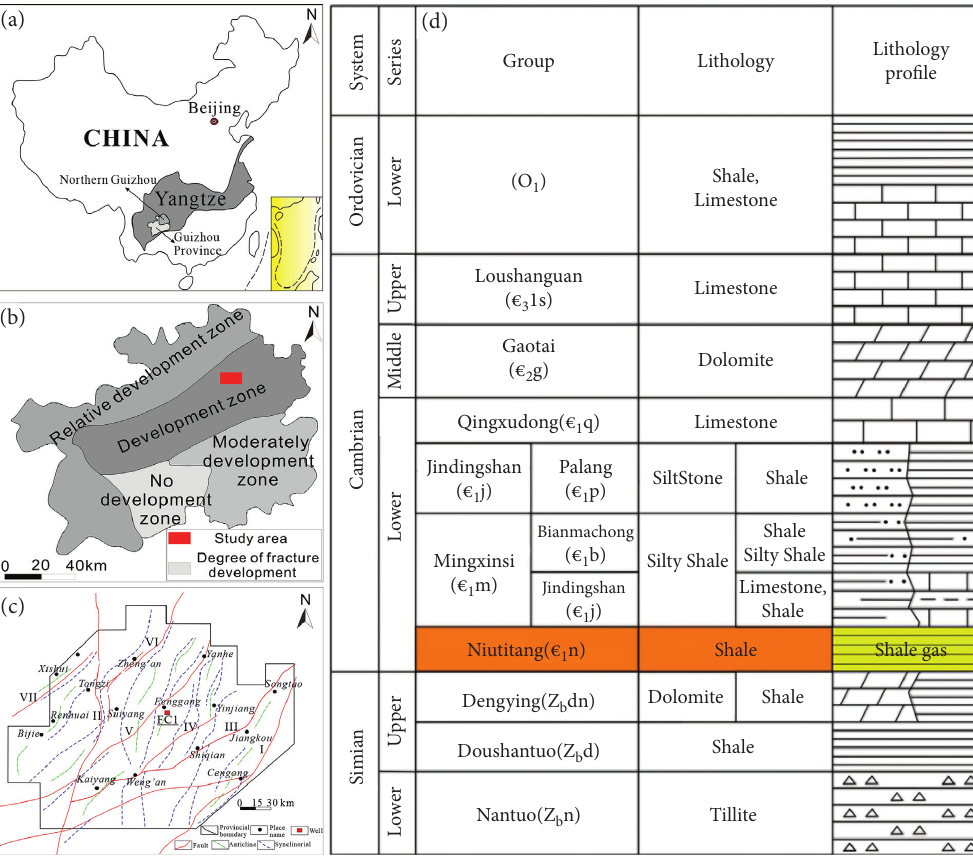
Figure 1: Regional geological overview of the study area ((a) location of the study area; (b) extent of fracture development; (c) tectonic development; (d) stratigraphic lithological Table 1: Basic sample parameters and mineral content.